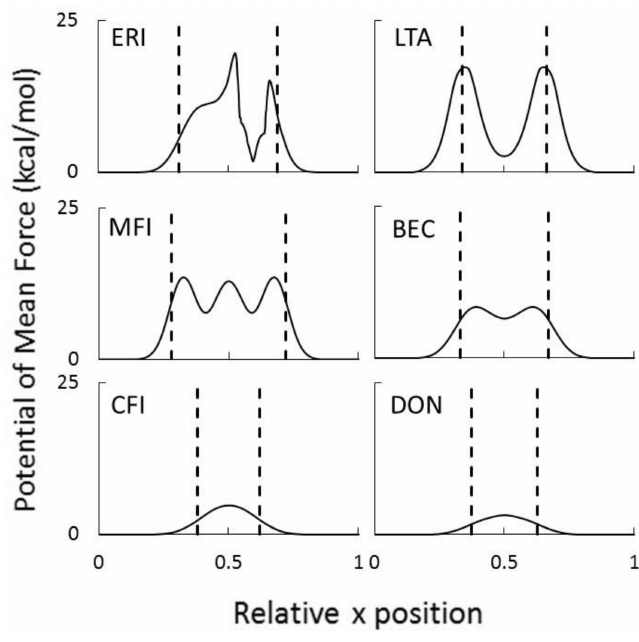
Figure 9. Potentials of mean force for hydrated V 2+ ion passing through the 6 membrane framework types at 325